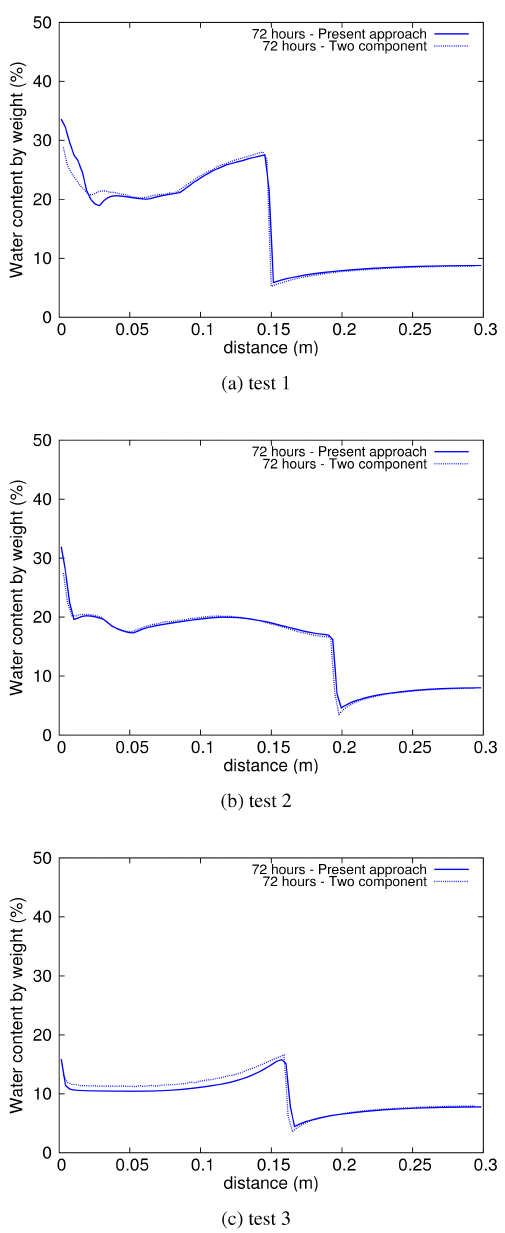
Figure 3. Comparison of simulated results from present ap- proach with two-component approach in Painter (2011). The parameters used are permeability = 3.5 × 10 − 12 m 2 , thermal conductivity (dry) = 0.25Wm − 1 K − 1 , thermal conductiv- ity (wet) = 2.3Wm − 1 K − 1 , α u = 0.45, α f = 0.95, thermal conductivity (frozen) = 3.6Wm − 1 K − 1 , porosity = 0.5, soil density = 2700kgm − 3 , specific heat = 837Jkg − 1 K − 1 and tortuosity = 0.01. The van Genuchten parameters used were α = 2 × 10 − 4 Pa − 1 and λ =